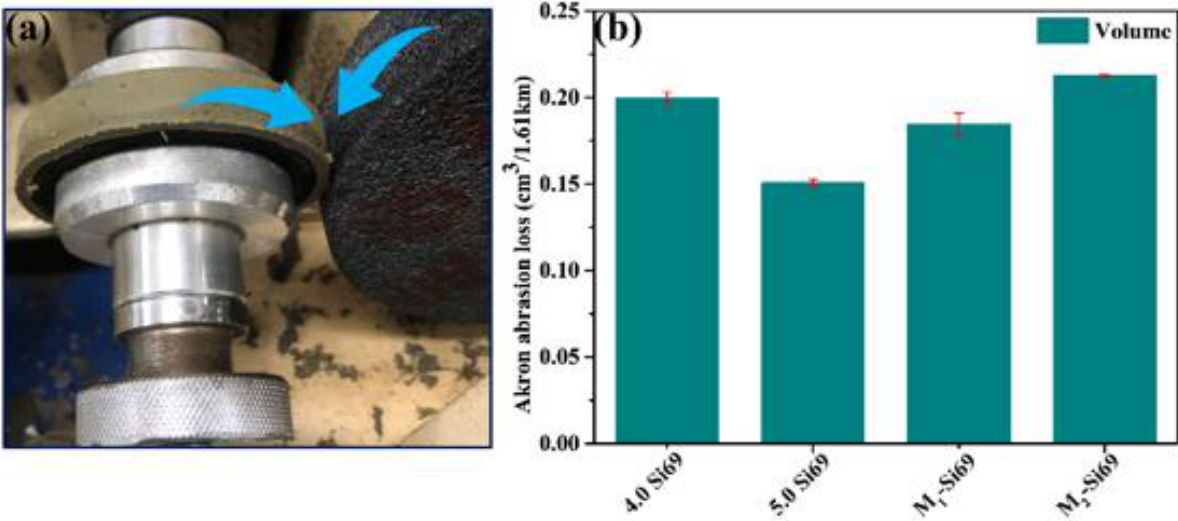
Figure 14. ( a ) Model of Akron wear test; ( b ) Akron wear volume.